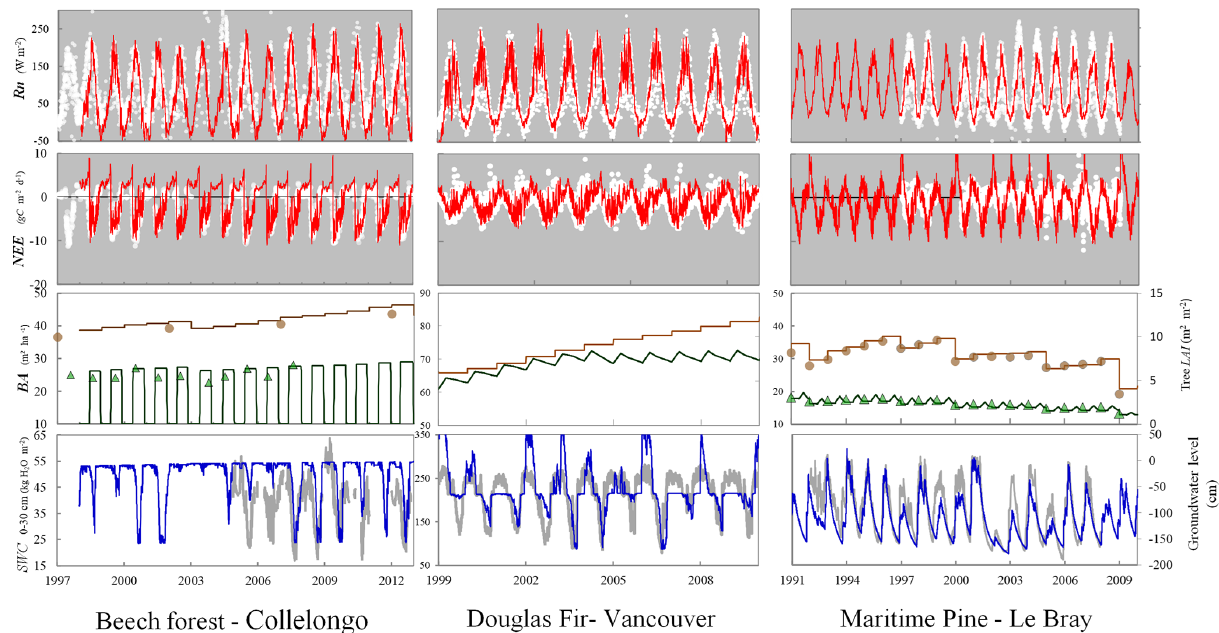
Figure 14. Time series of net radiation and CO 2 fluxes observed (symbols and grey lines) and predicted (coloured lines), top two rows, together with stand basal area, leaf area index and soil water stock or groundwater level, bottom two rows. Left: Collelongo European beech forest. Centre: Douglas fir stand in British Columbia. Right: Le Bray pine forest. Sources of the data used are detailed in Table 4. The model was initiated in 1997 for the Collelongo experiment, 1998 in the Douglas fir and 1987 for the Le Bray experiment. The soil water content in the top 30 or 60cm observed at the Collelongo or Douglas fir sites (left axis of bottom row) is compared with soil water content (SWC) in the rooted zone simulated by GO+. At the Le Bray site, the groundwater level is compared for the 1994–2008 period (right